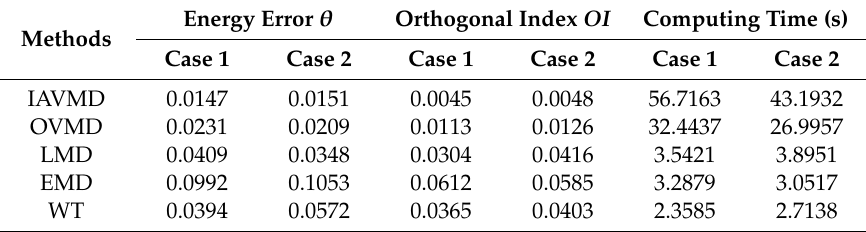
Table 2. The quantitative comparisons among di ff erent approaches in the simulation signal.